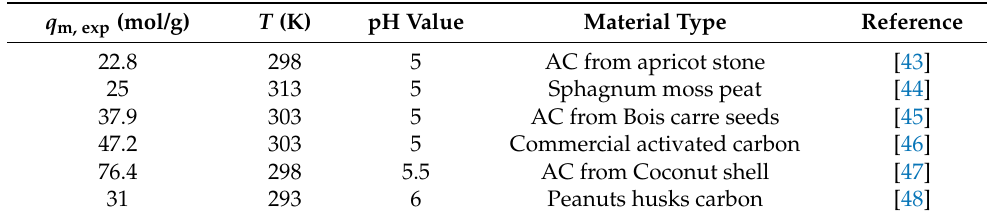
Table 7. Parameter values for the different linear models.